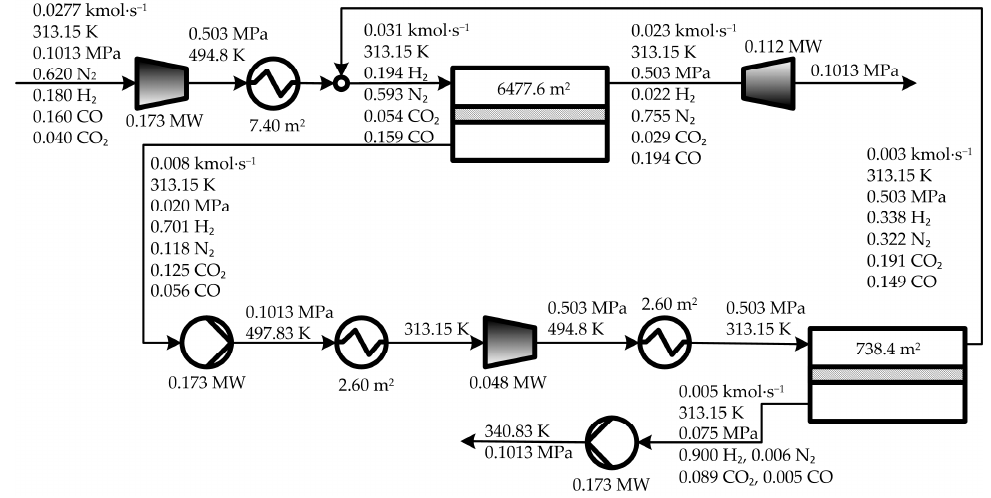
Figure 8. Sub-optimal solution SUBOPT2, in which the driving force for permeation is created by combining compression and vacuum and the expander is included for power recovery.